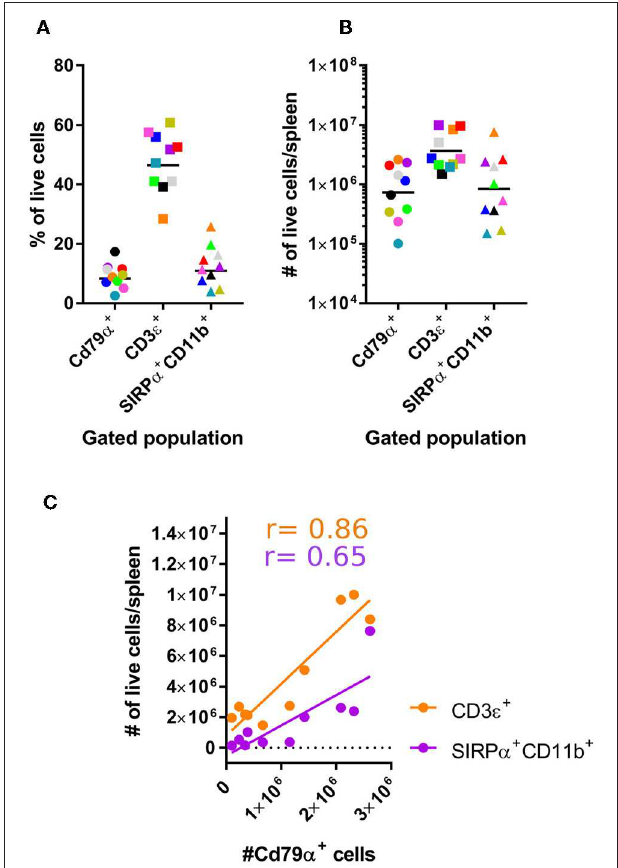
FIGURE 3 | Enumerating lymphocyte and DC populations in M. condylurus spleen. Single cell suspensions were prepared from spleen and stained with the antibody panels indicated on the x-axis in (A) and the percentage of Cd79 α + , CD3 ε + , and SIRP α + CD11b + cells from 10 individual M. condylurus bats are shown. Cell number was calculated according to (% of marker positive population × [% viable cells x (total cell count)]-number of marker positive cells identified in isotype control stained samples) × total volume spleen (B) . An xy plot correlating CD79 α + cell number with CD3 ε + and SIRP α + CD11b + cell numbers is presented (C) with Pearson correlation r